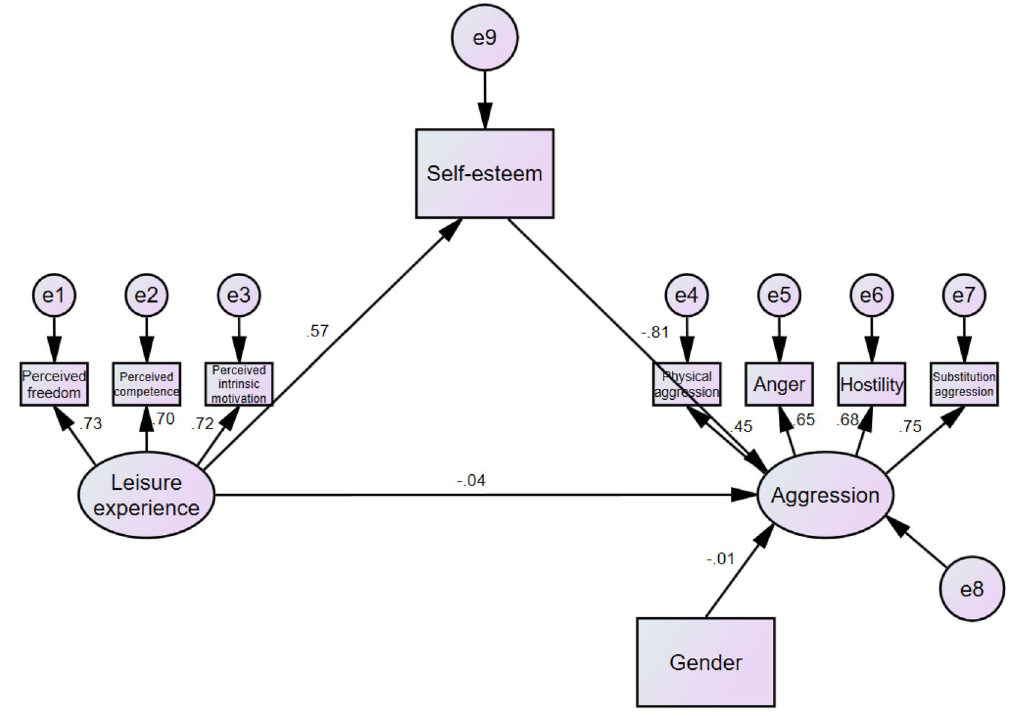
Figure 3. Indirect effect of leisure experience on aggression, mediated by self-esteem (Model 2).